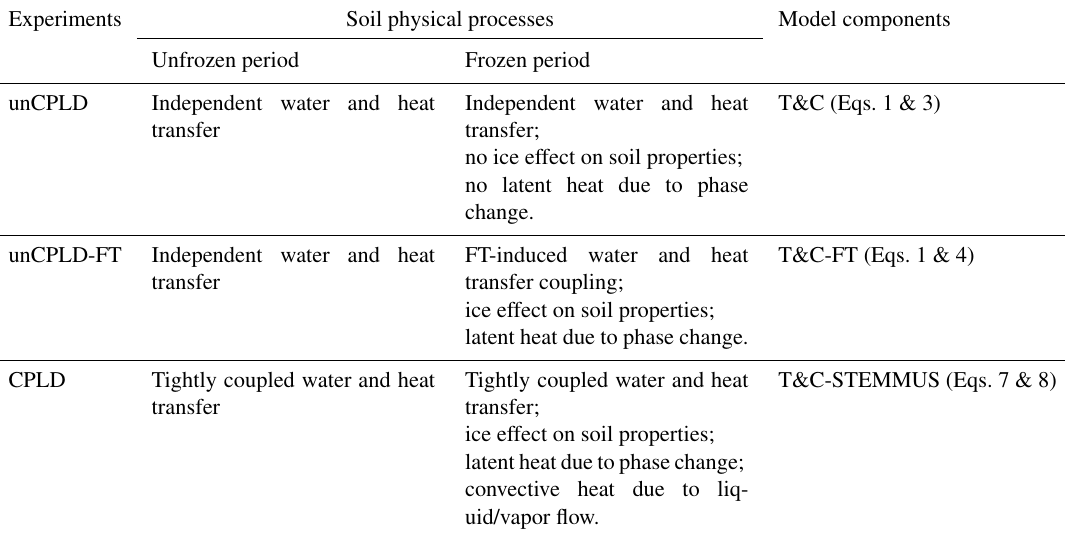
Table 1. Numerical experiments with various mass and energy transfer processes.